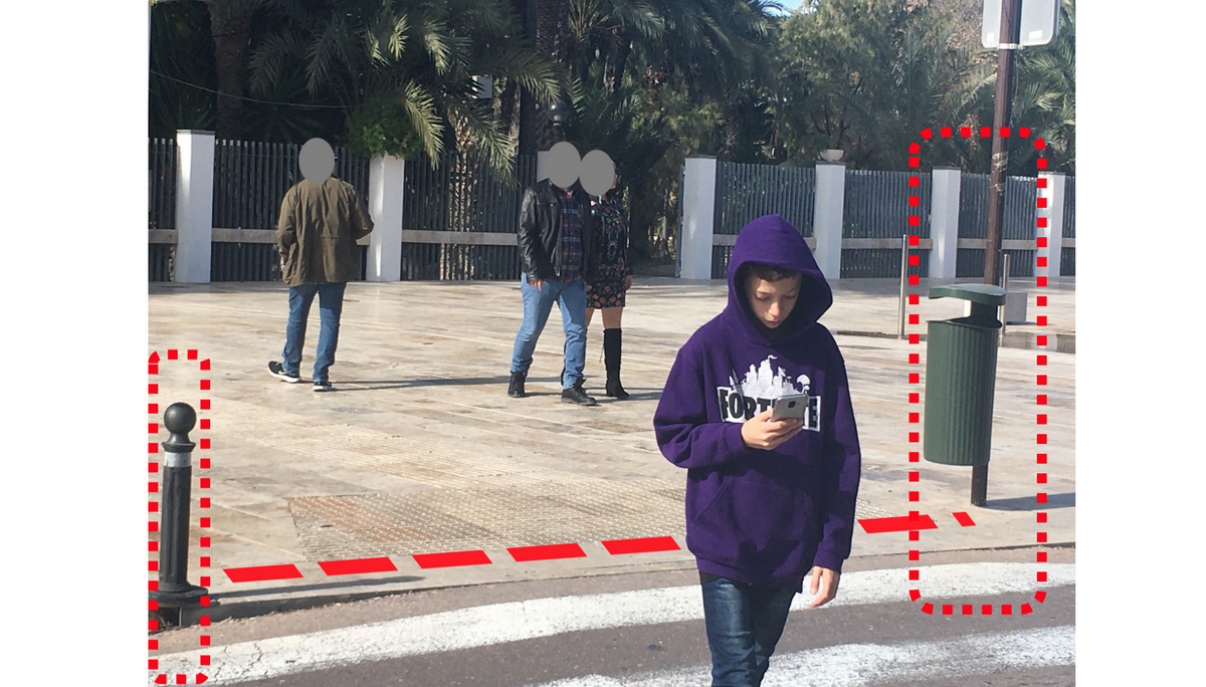
Figure 2. Defining a visual crossing line between 2 points on the street, for example, the bollard and the street litter bin, to not introduce bias and to count only the pedestrians moving in one of the two directions between the crossing